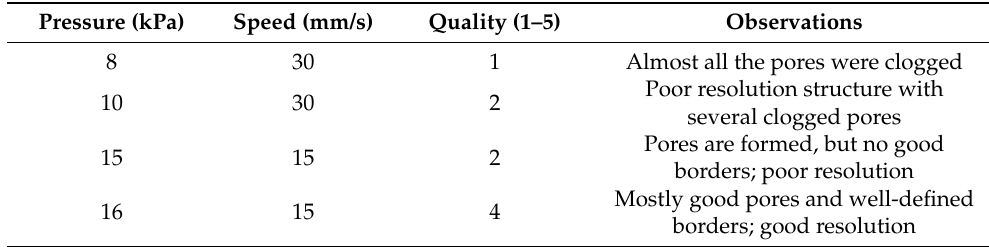
Table 4. Observations of the A8-G6 bioprinted scaffold based on different printing parameters. The quality (print resolution) of the constructs were rated on a scale from 1 to 5, with 1 being the lowest resolution and 5 being the highest.